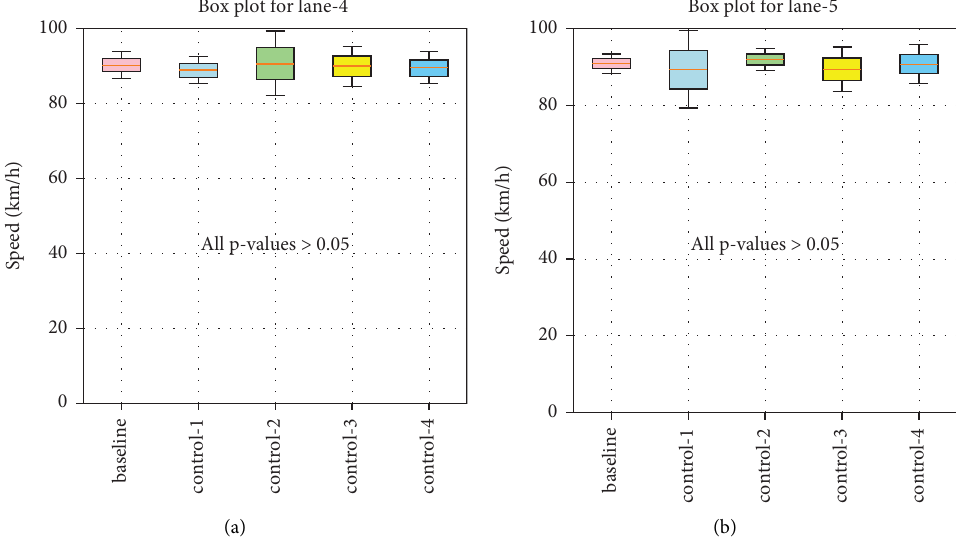
Figure 13: Vehicle speed distribution for diferent control strategies in lane-4 and lane-5. (a) Vehicle speed distribution in lane-4. (b) Vehicle speed distribution in